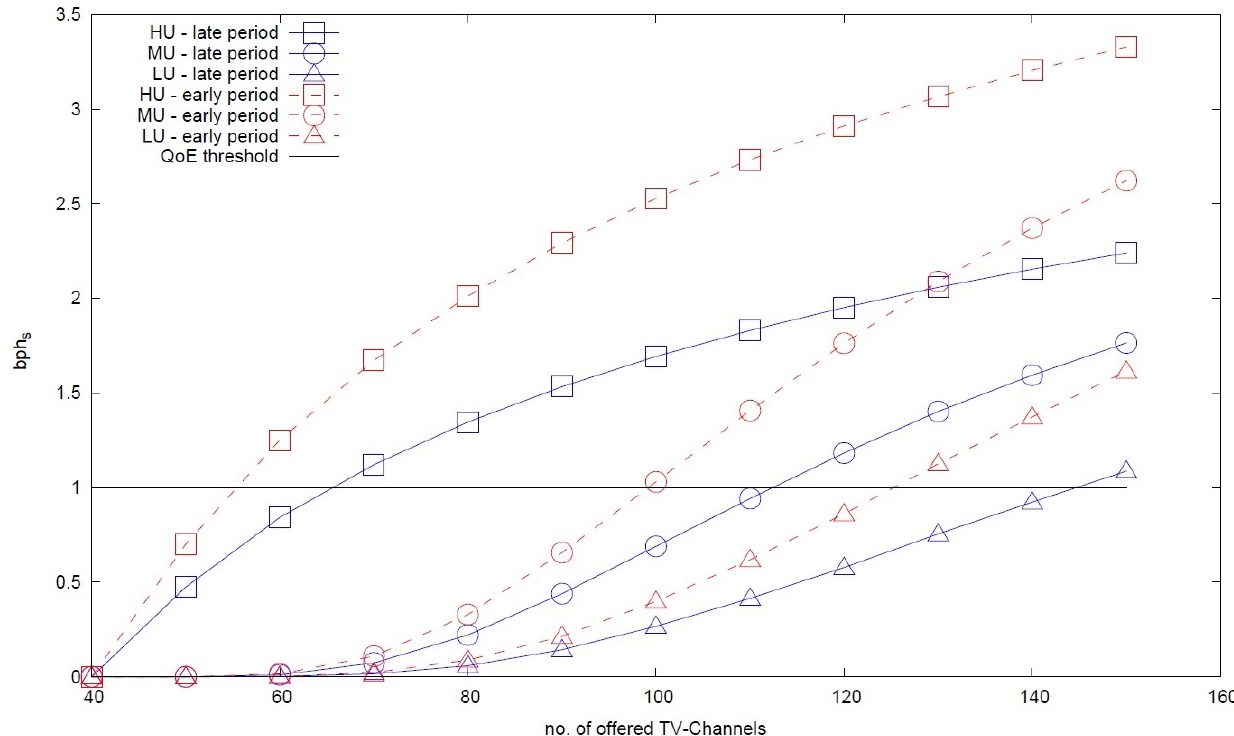
Figure 3. bph dependent on the number of offered channels for different traffic scenarios s for both analytical